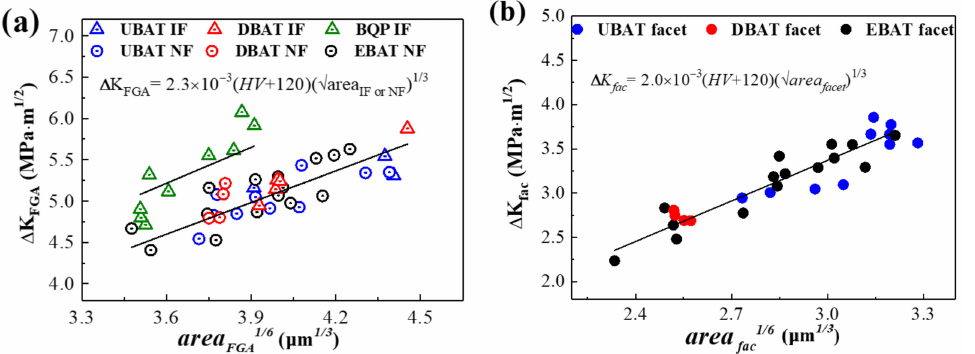
Figure 9. ( a ) Variation of ∆ K FGA vs. area FGA1/6 and ( b ) variation of ∆ K fac vs. area fac1/6 for bainitic steels; IF: inclusion-induced FGA, NF: noninclusion-induced